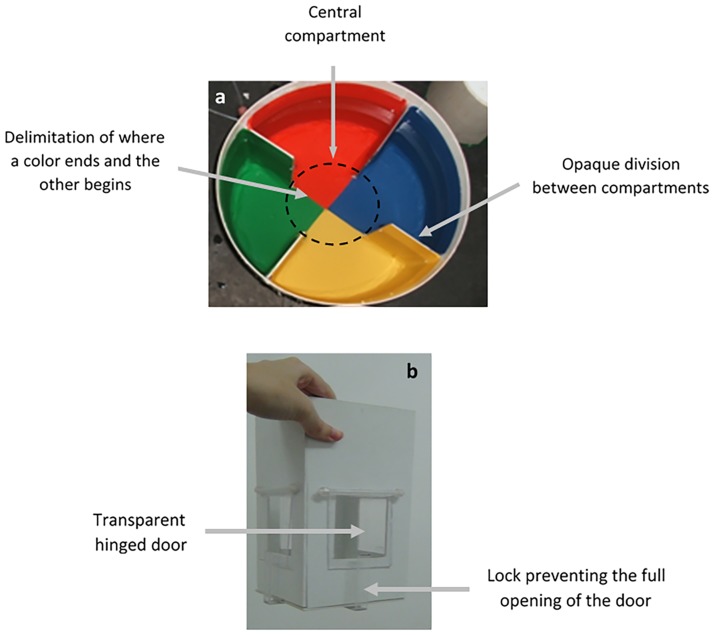
Overhead view of a circular test aquarium showing the four compartments with the same volume and area and the white, opaque chamber used in the motivation test.A) Each compartment was covered on the inside with adhesive paper of a different color (red, yellow, green or blue). The central compartment was formed by the junction of the background colors of the other compartments. The aquarium diameter was 40 cm; the water column height was 15 cm. The outer walls and the internal partitions were opaque and of the same color as the rest of the compartment. The test aquaria were randomly distributed within the testing area of the lab and the position of the colored compartments was changed for each fish to minimize any possible environmental bias in our results. B) Transparent locks attached to the bottom of the chamber prevented the complete opening of the transparent doors. Thus, fish could touch and move the doors, but could not completely open them and leave the central chamber. Chamber size = 10 x 10 x 22 cm.